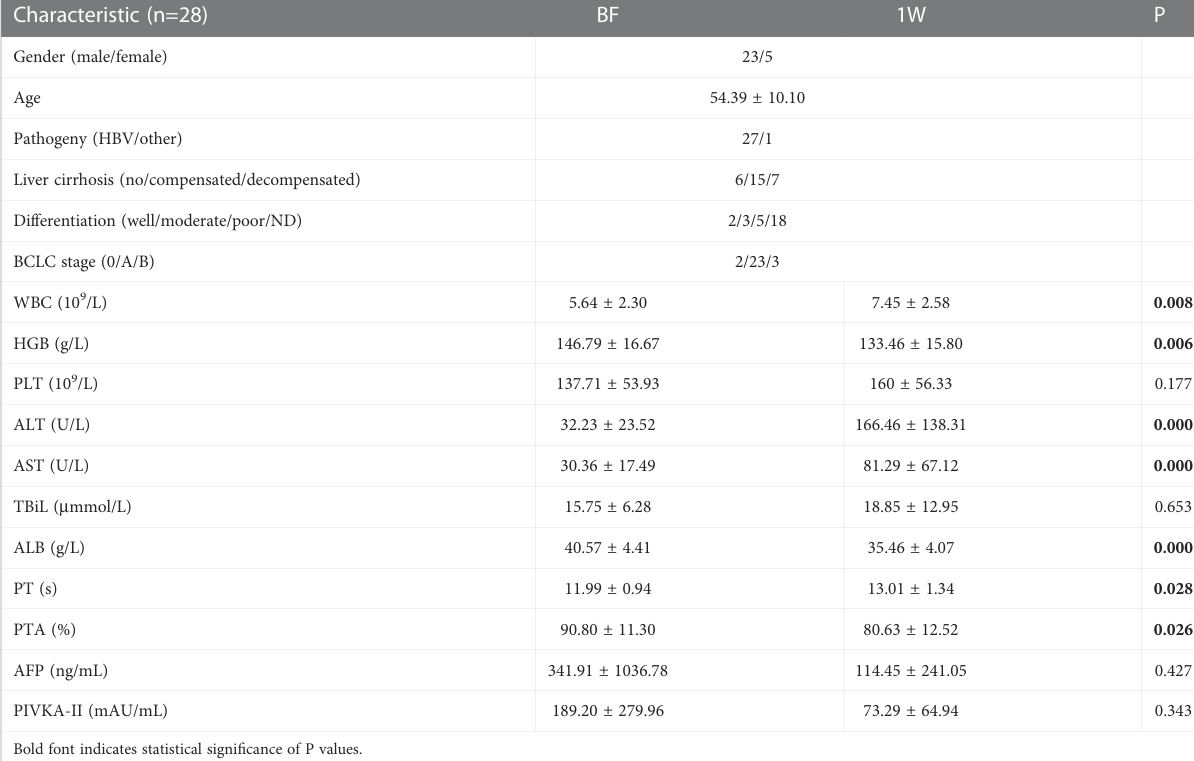
TABLE 2B Characteristics of patients in the BF and 1W cohort.